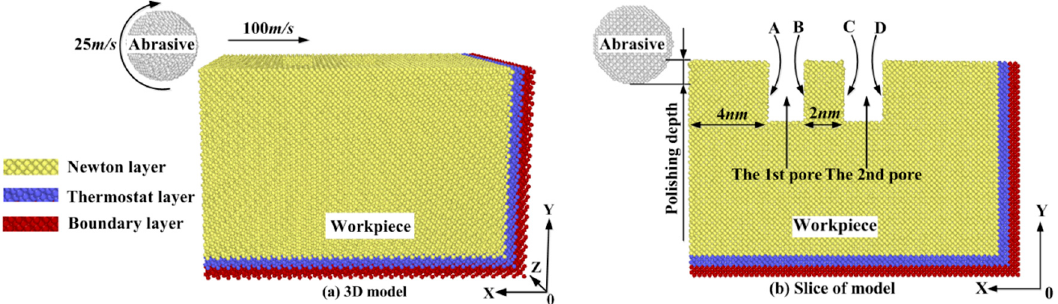
Figure 1. Schematic diagram of the diamond abrasive polishing single crystal silicon.